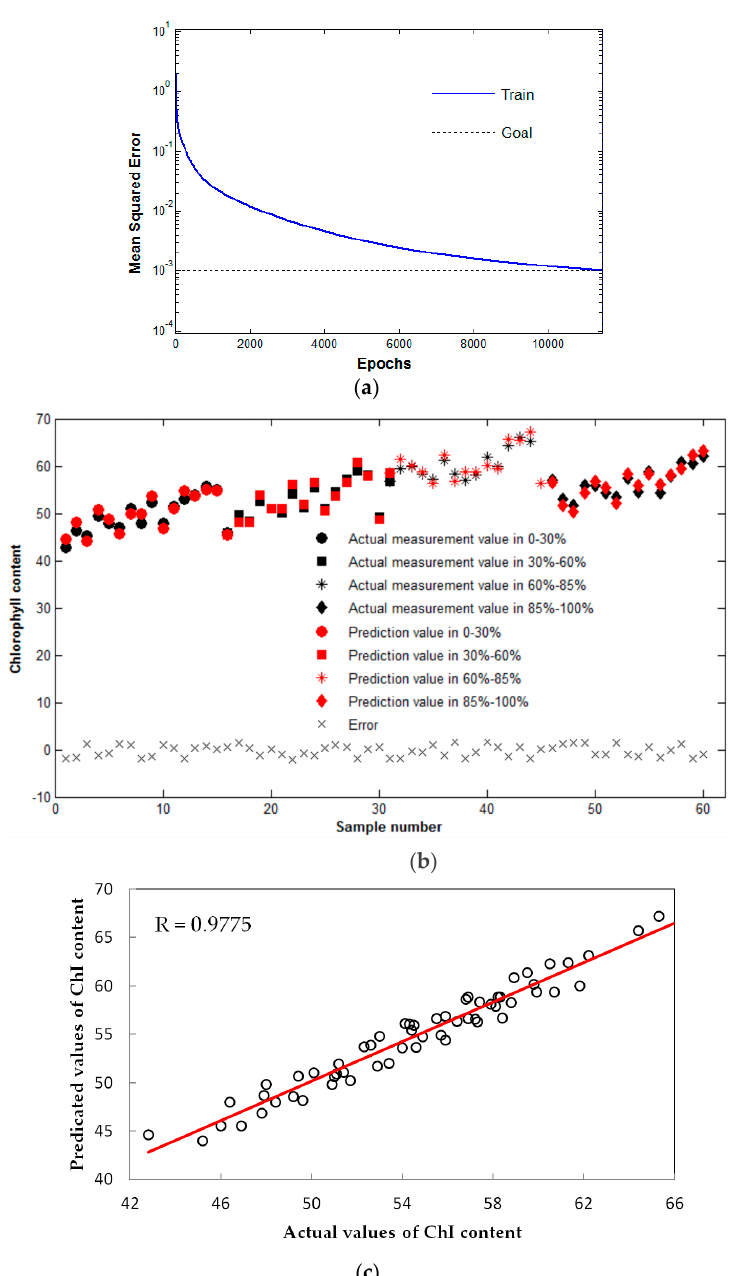
Figure 10. Convergence effect and prediction ability of the ANN. ( a ) Network convergence; ( b ) Prediction result; ( c ) Correlation between actual values and predicted values of Ch1 content.